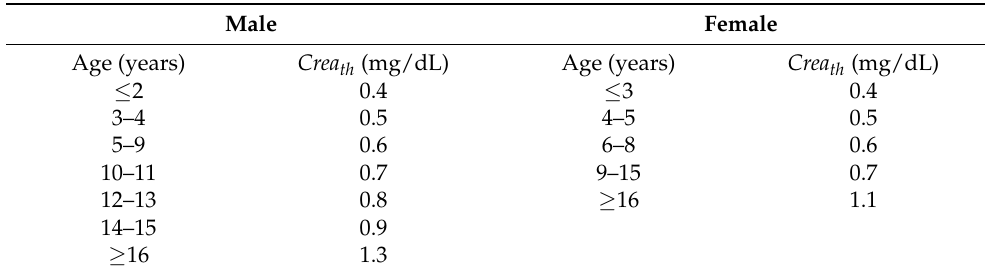
Table 2. Creatinine threshold values ( Crea th ) adopted in the present study according to patients’ gender and age.